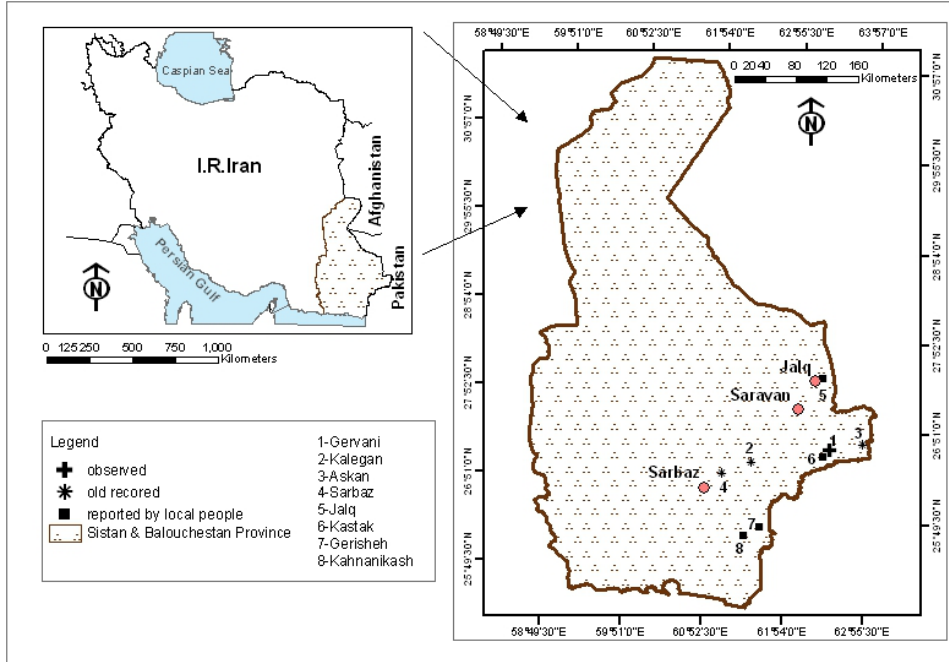
F IGURE 1 . Distribution of Calotes versicolor in Sistan and Baluchestan province, southeast of Iran.